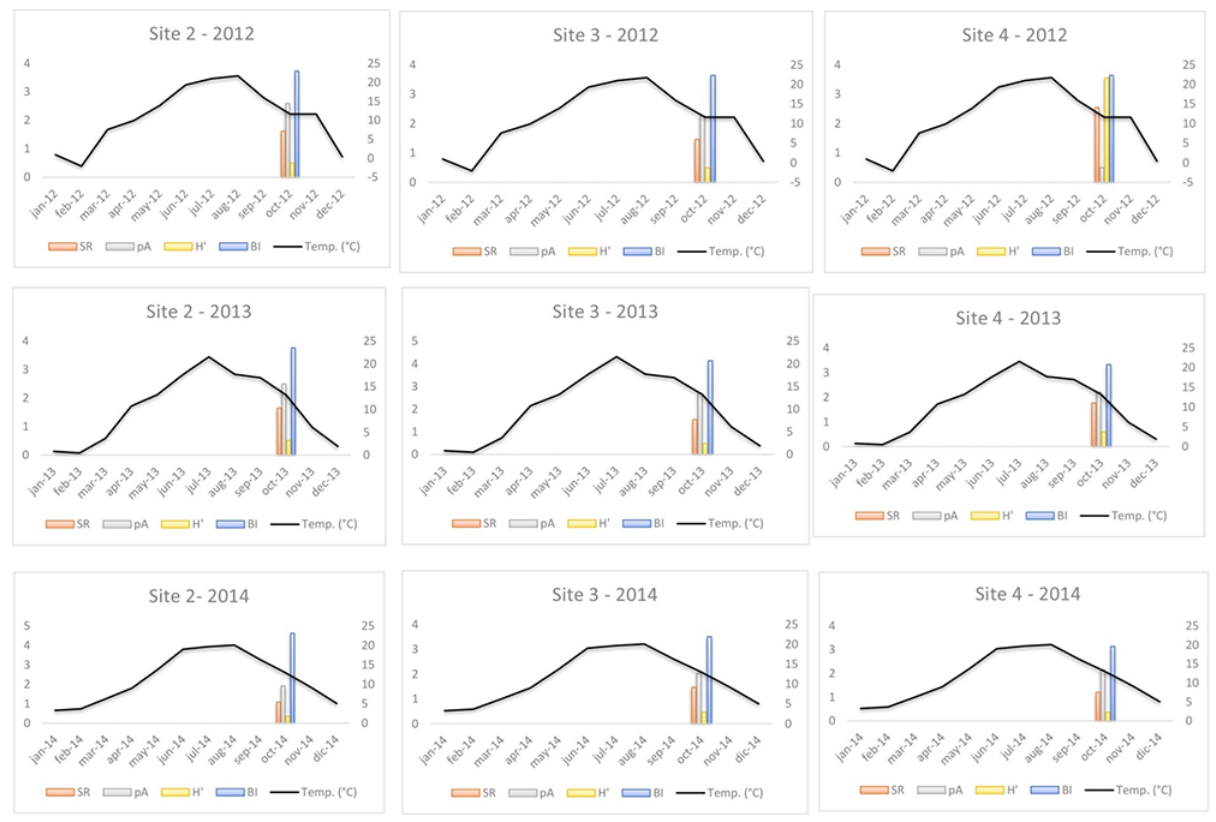
Figure 5 Graphical comparison of mean monthly temperatures detected during each surveyed year (2012–2014) in Sites 2, 3, and 4 with macrofungal biodiversity indices (in logarithmic scale). SR – species richness; pA – population abundance; H ′ – Shannon Index; BI – Biomass Index. Temperatures are expressed in